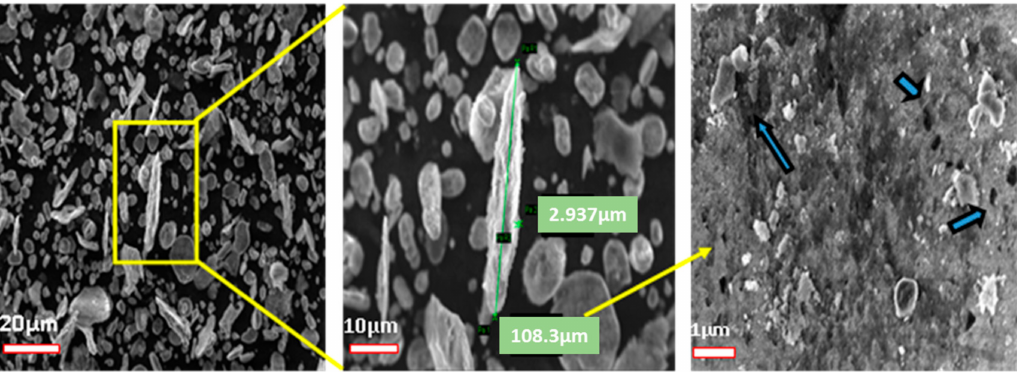
Figure 9. GNPs/Al composite powder is showing particle morphology with magnified view and presence of GNPs on the